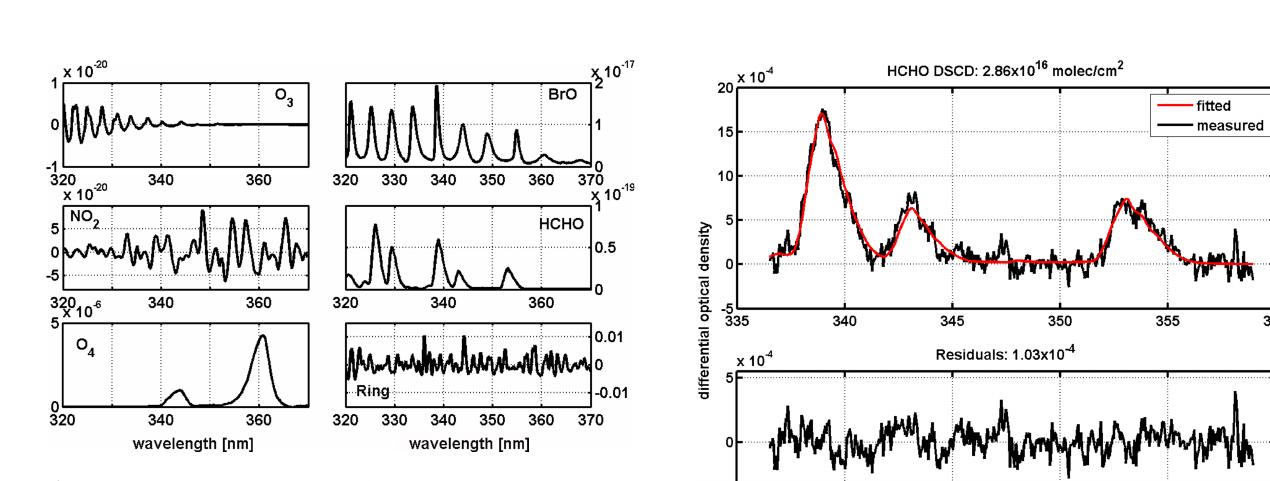
Fig. 1. Absorption cross sections of the main trace gases absorb- ing in the 320–370nm spectral range and of the Ring effect. All absorption cross sections are expressed in cm 2 molec − 1 , except O 4 ( × 10 − 40 cm 5 molec − 2 ) and have been smoothed to match the res- olution of the BIRA-IASB instrument (0.38nm FWHM).